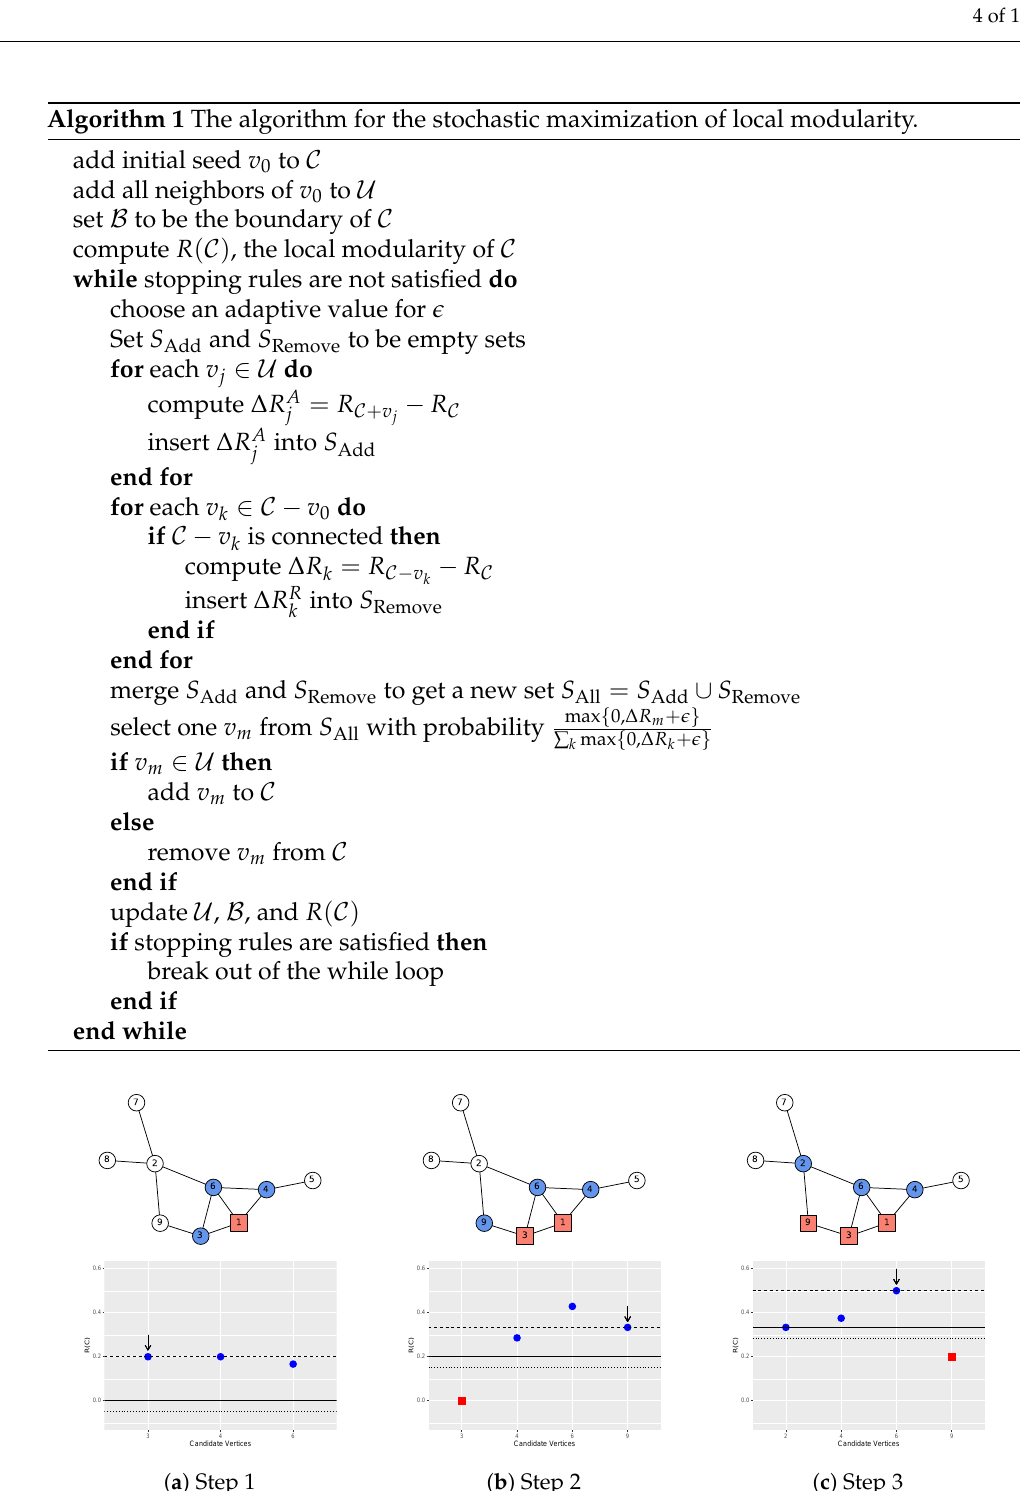
Figure 2. An illustration of the search algorithm. It shows the first three steps in the search for the local community of vertex